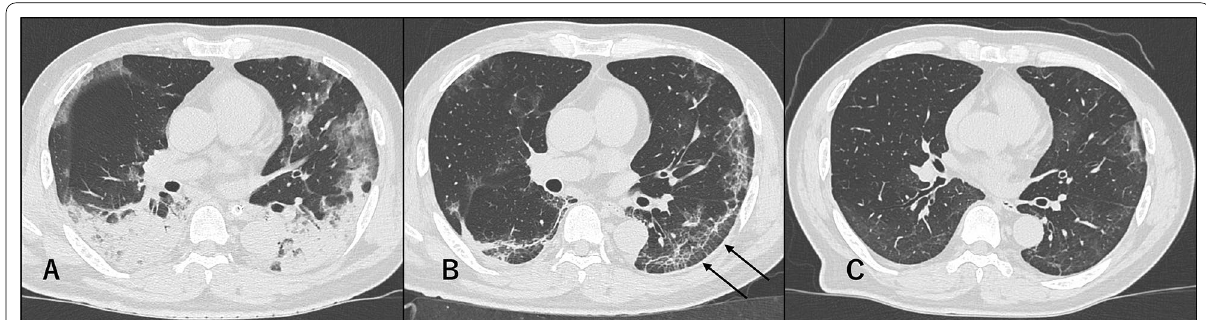
Fig. 2 Severe COVID-19 pneumonia in a 59-year-old man. a At intubation (14 days after symptoms onset): Multiple GGOs and consolidation in the subpleural areas of both lungs were observed. Air bronchogram was also detected inside the consolidation. b At discharge (21 days after symptoms onset): Bilateral and posterior subpleural lines and interlobular septal thickening (arrows) appeared. c At 1-month follow-up (53 days after symptoms onset). GGOs with decreased extent and density could still be observed